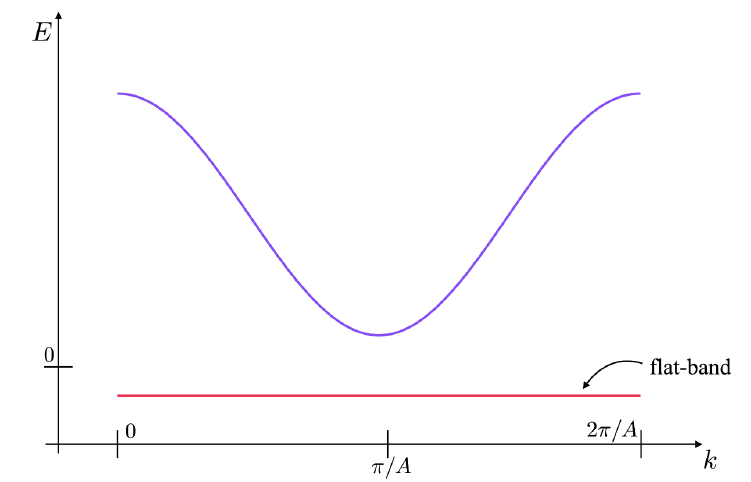
Figure 4 . The two dispersion bands, with the lower one being perfectly flat, for γ 0 = γ > 2 t